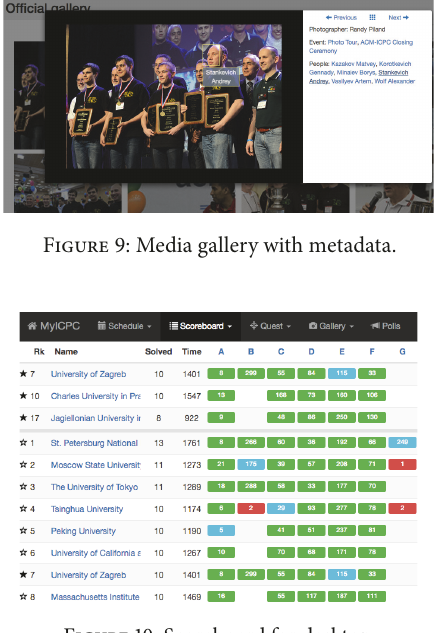
Figure 10: Scoreboard for desktop.